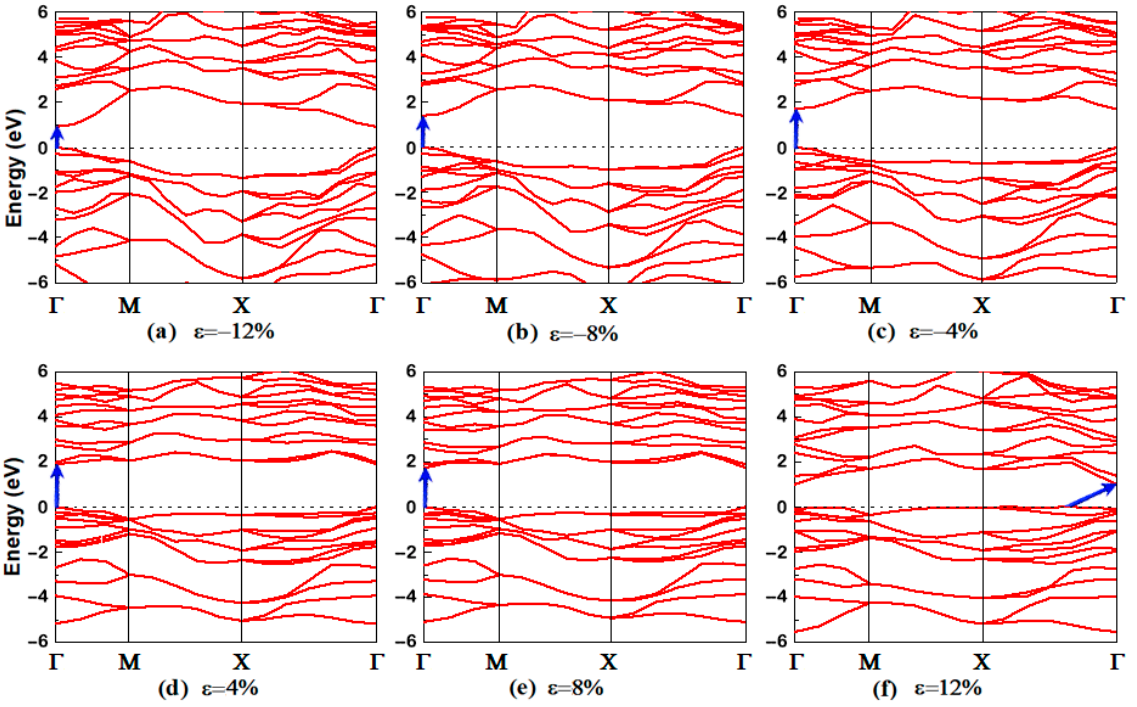
Figure 7. Band structure change for the V-AlP bilayer induced by external biaxial strain. Five cases, including figures ( a – e ), show the direct band gaps (vertical arrows), while ( f ) shows an indirect band gap (diagonal arrow).